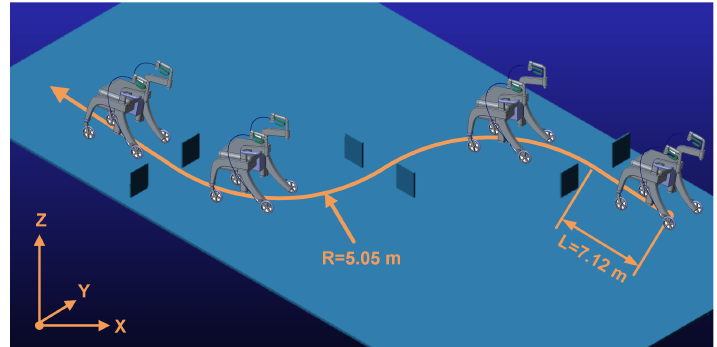
Figure 12. The tracking results of NMPC.